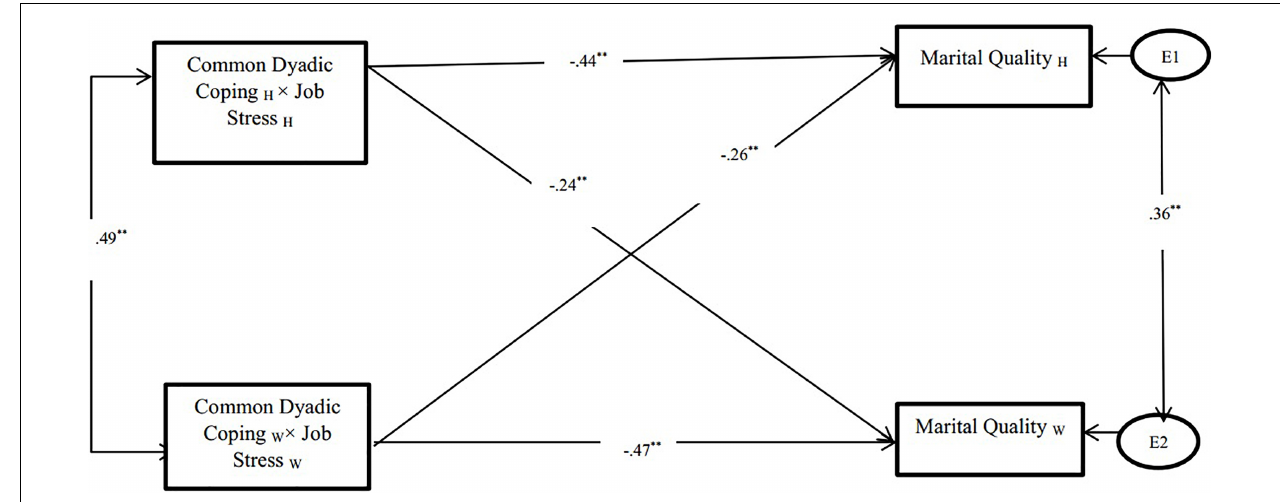
FIGURE 3 | Association between common dyadic coping and marital quality. ∗∗ p < 0.01; W, Wives; H, Husbands.